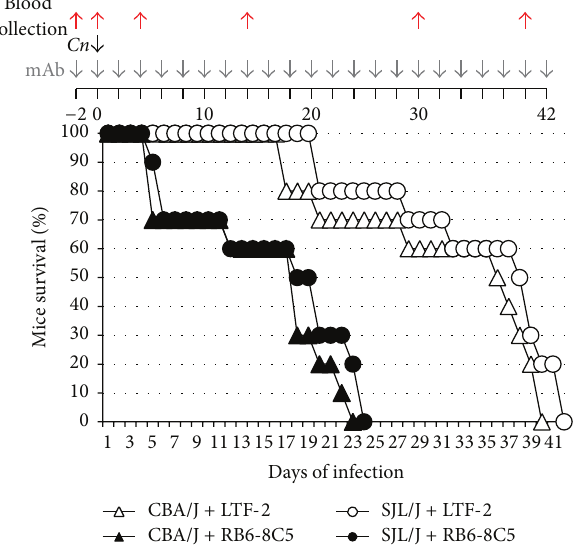
Figure 1: Neutrophils are important to control cryptococcosis in mice. Four six-week-old mice (CBA/J or SJL/J model) were treated intraperitoneally every other day with 300 𝜇 g of Rb6- 8C5 monoclonal antibody (mAb, gray arrows) directed against neutrophils. After 2 days from the first dose (day 0), mice were infected intranasally with a lethal dose of C. neoformans cells ( 5 × 10 5 ) (black arrow). As controls, mice were treated with LTF-2 mAB (an IgG2 isotype for Rb6-8C5). Before mAb treatment and C. neoformans challenge, and during infection, blood was collected for neutrophil count (red